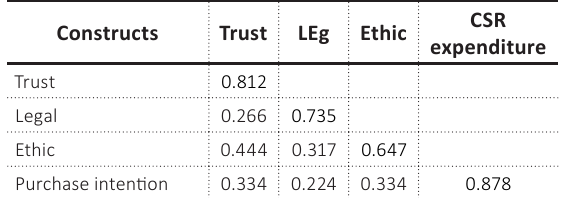
Table 3. Discriminant validity